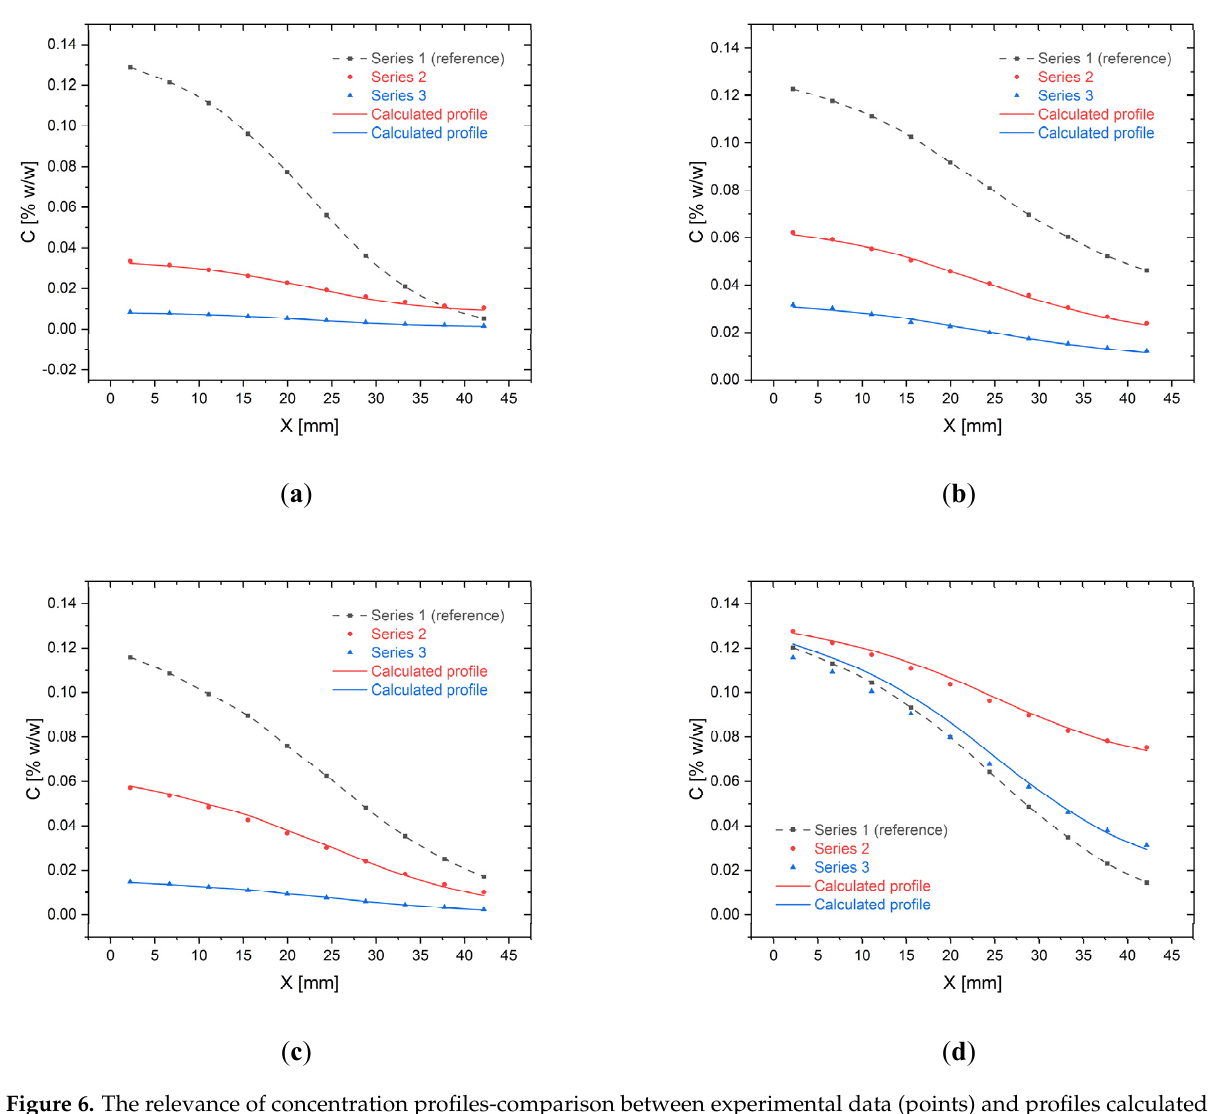
Figure 6. The relevance of concentration profiles-comparison between experimental data (points) and profiles calculated from Equation (1) (lines) for different dilution ranges and starting concentrations: ( a ) Profiles for 4 µ L SV and 15 tilts; ( b – d ) Profiles for 4 µ L SV and 25 tilts.